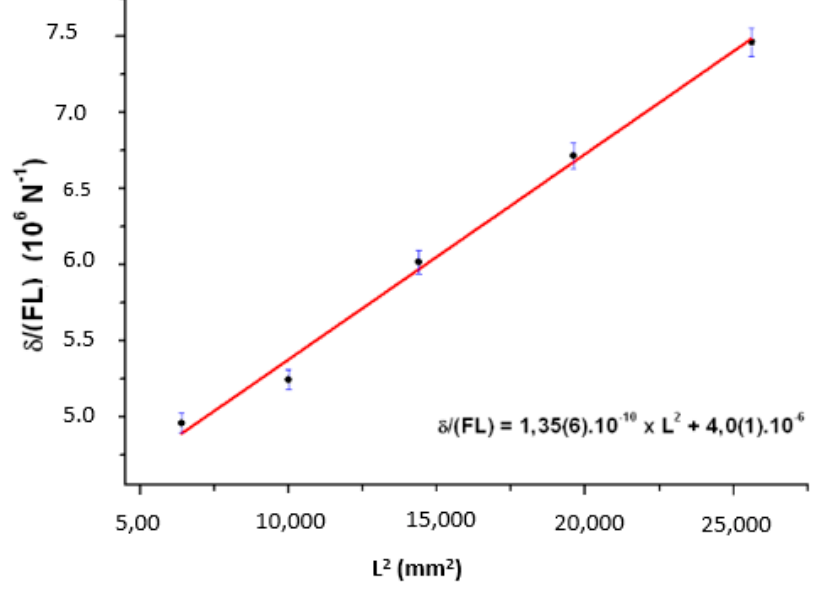
Figure 8. The curve of the δ / ( FL ) = L 2 to determine the Young’s modulus ( E ) and the shear modulus ( G ).